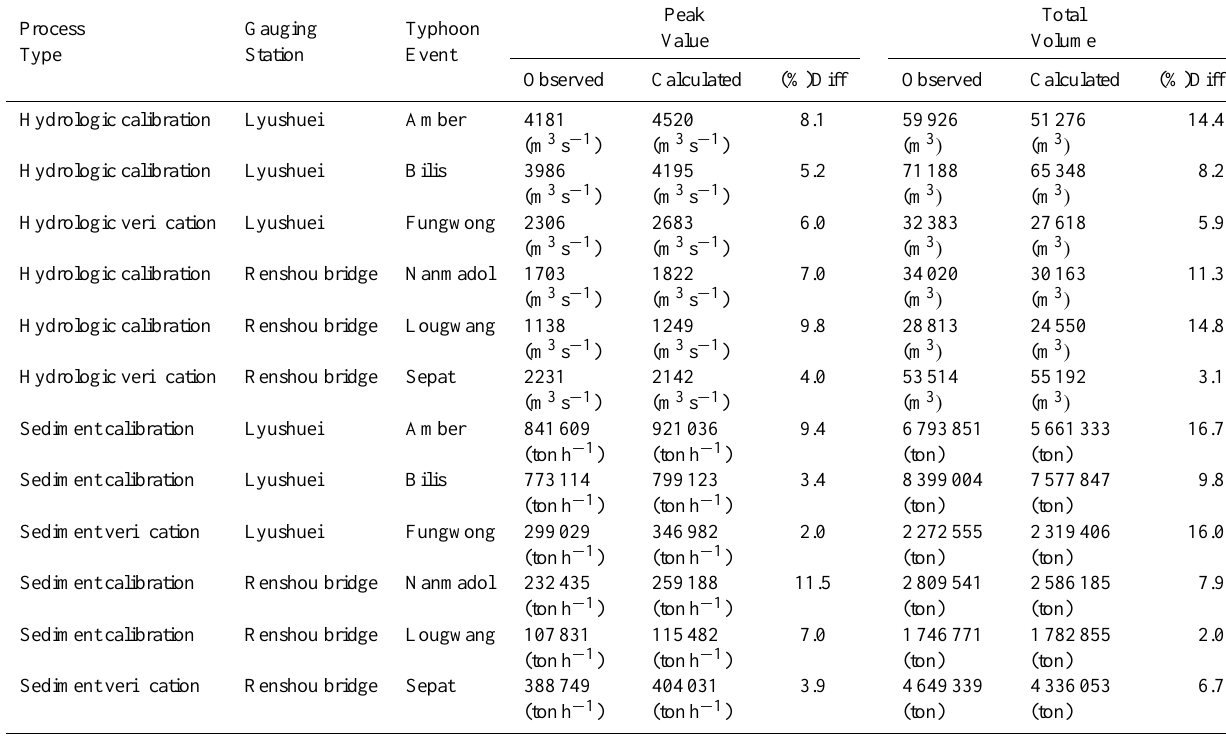
Table 1. Calibration and verification